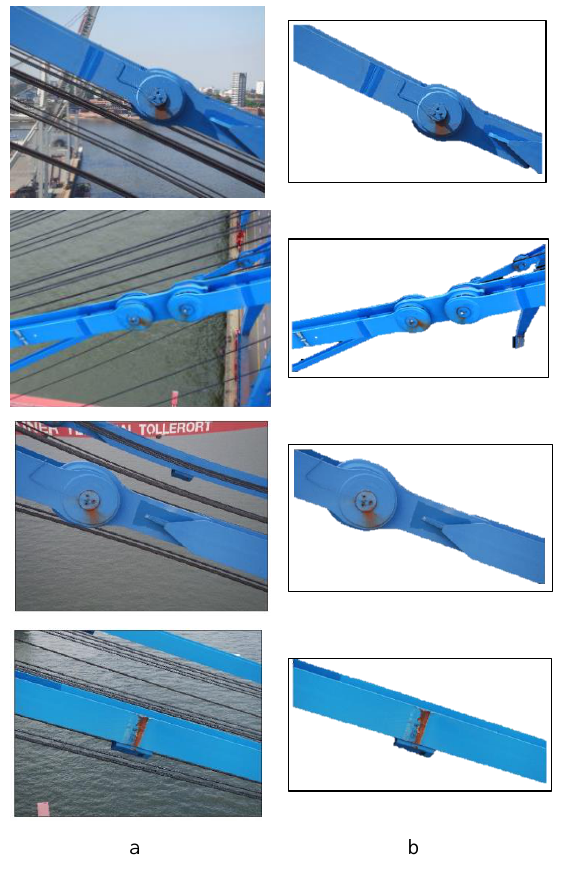
Figure 9. Foreground-background separation results.